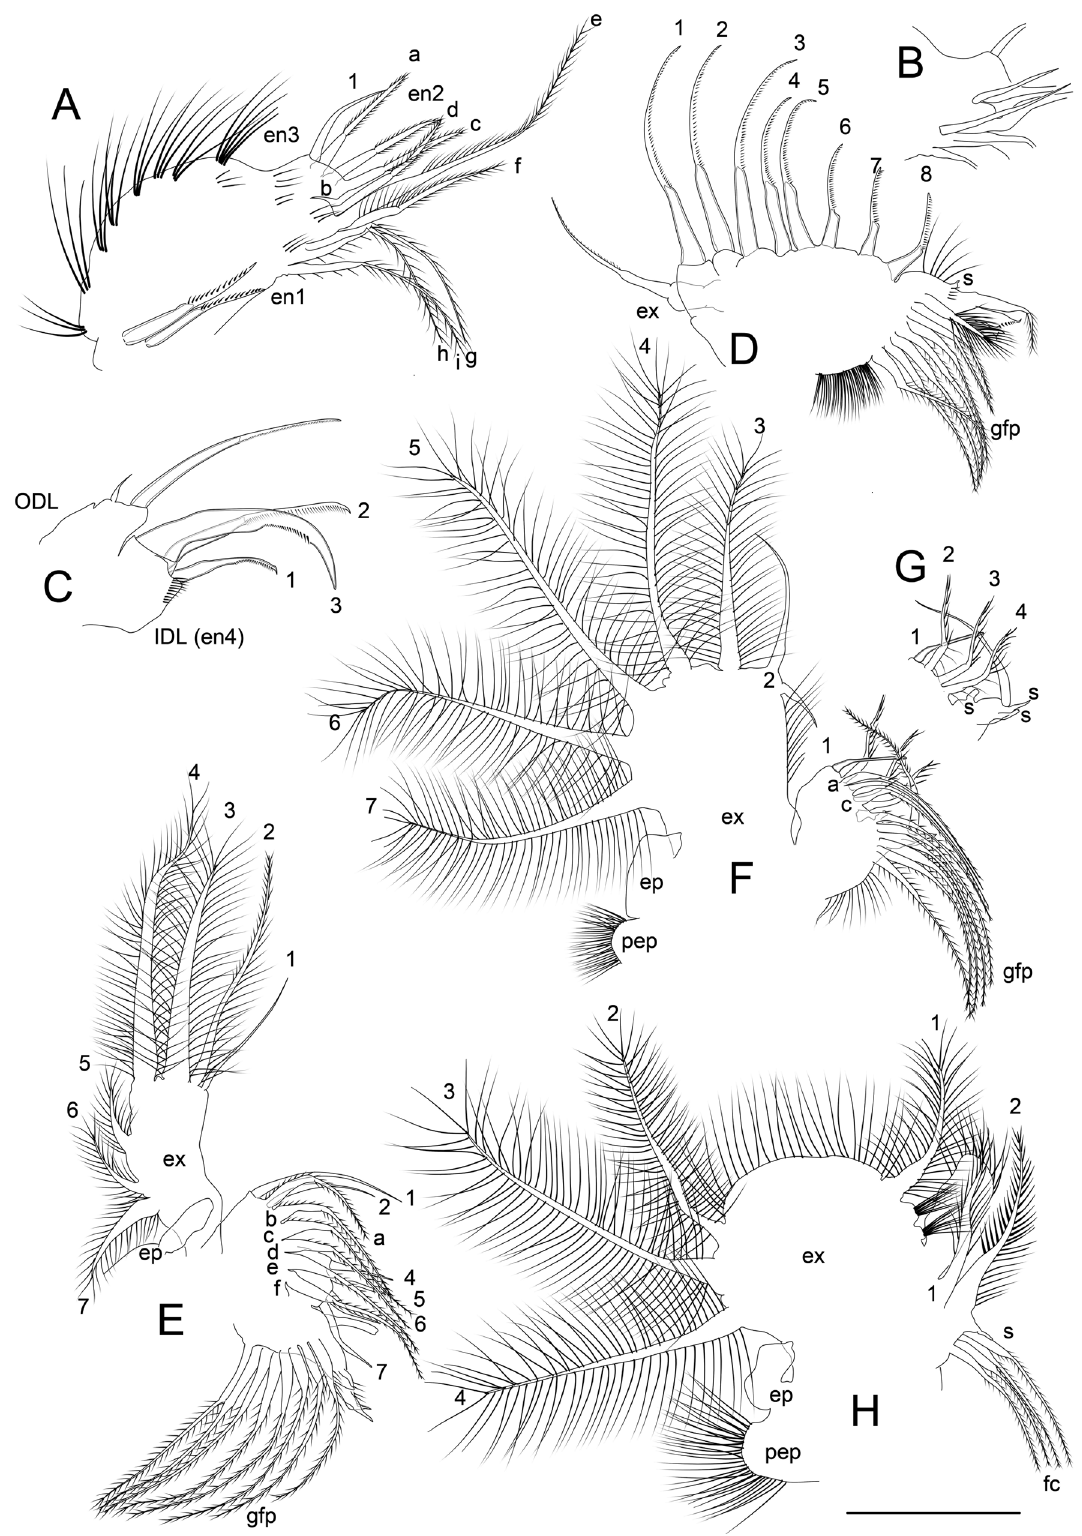
Fig. 5. Disparalona (Mixopleuroxus) hamata (Birge, 1879), parthenogenetic female. A . First limb. B . Idem , stiff setae. C . Idem , ODL and IDL. D . Second limb. E . Third limb. F . Fourth limb. G . Idem , distal endite. H . Fifth limb. Scale bar = 50